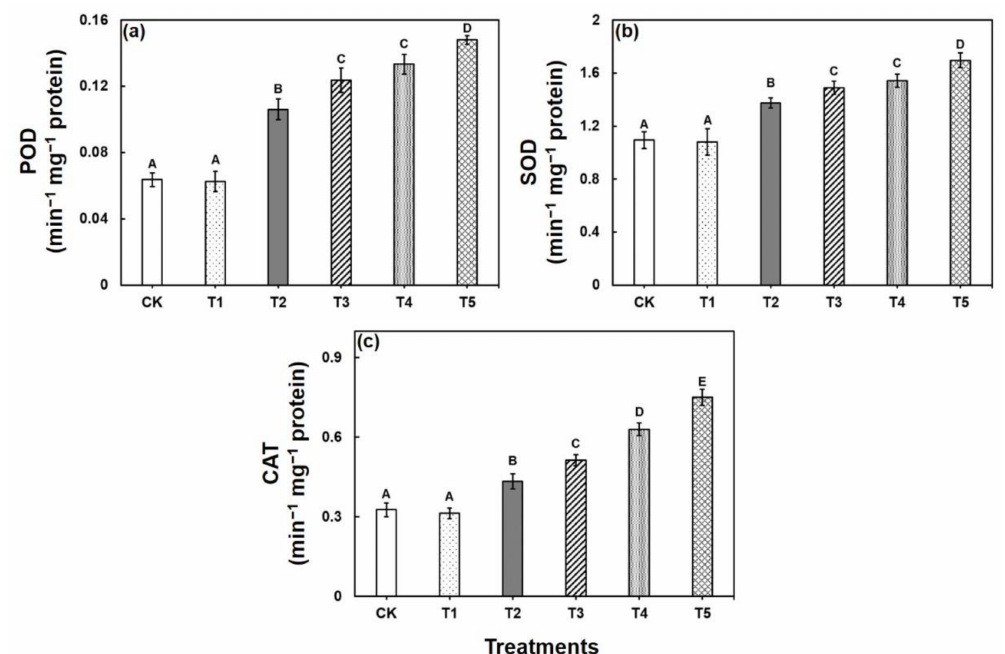
Figure 2. Effect of exogenous Cu and CA on enzyme activities ( a ) POD, ( b ) SOD, and ( c ) CAT in leaves of B. napus L. seedlings with 0, 25, and 50 µ M and 0 or 1.0 mM CA. Each value represents the mean of three replicates ± SE. Different letters indicate significant differences at p < 0.05 among treatments by Tukey’s